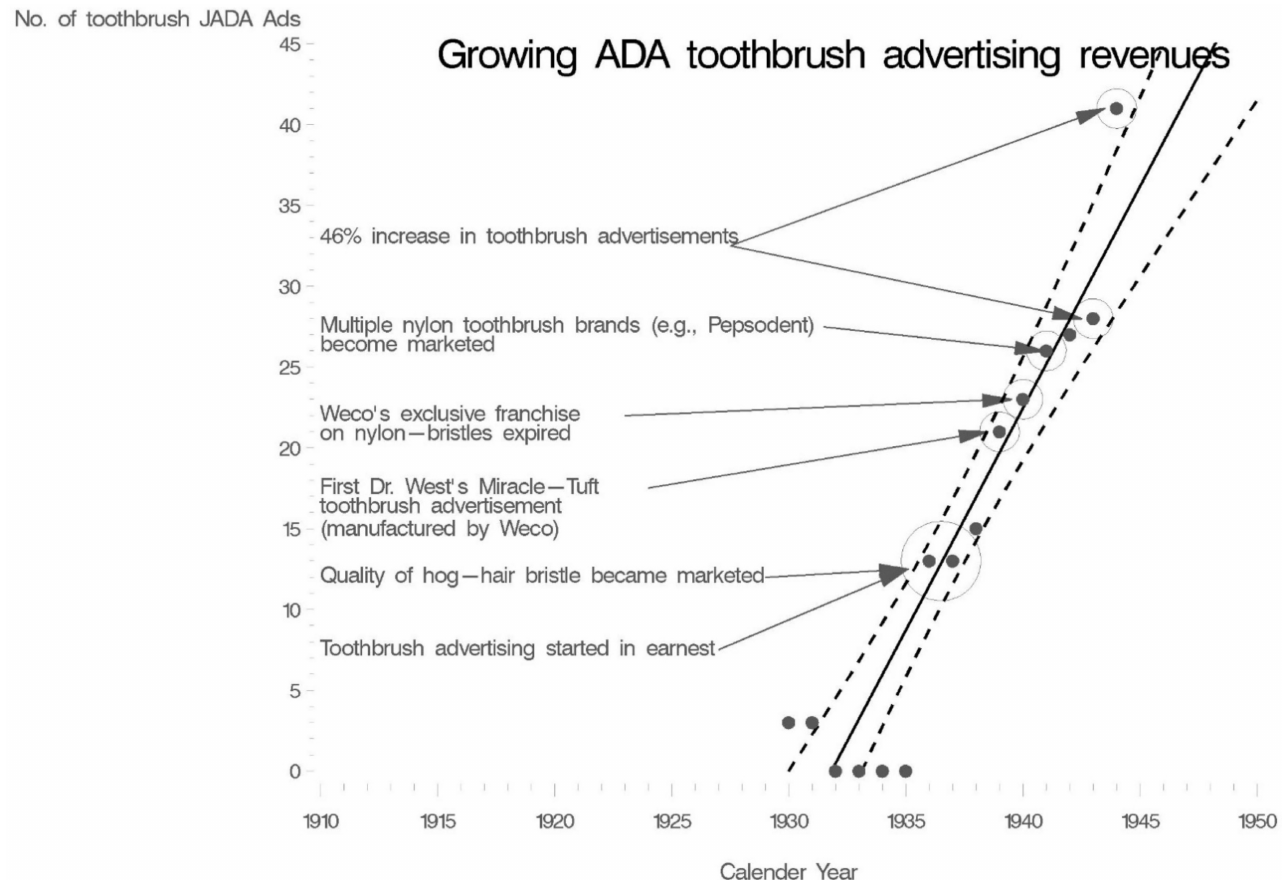
Figure 1. Toothbrush advertisements were a growing source of ADA advertising revenues. In 1942, the National Health Program Committee had reported a toothbrush was largely ineffective in dental caries control. In 1949, the ADA Council on Dental Health reported that “it is now believed that brushing of the teeth” is of value in dental caries control